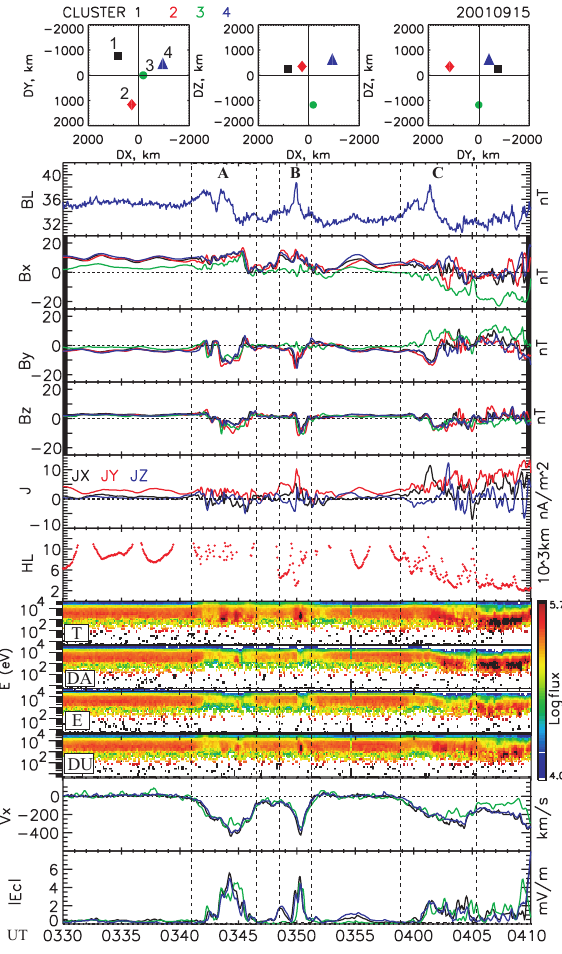
Fig. 2. Cluster spacecraft configuration and Cluster observations during 03:30–04:10UT on 15 September 2001. From top to bot- tom: The lobe magnetic field strength ( BL ), estimated assuming pressure balance; X , Y , and Z GSM components of the magnetic field from C1 (black), C2 (red), C3 (green) and C4 (blue); X , Y , and Z GSM components of the electric current, The Harris estimate of the current sheet half-thickness; Ion time-energy spectrograms from C3 HIA for tailward (T), dawnward (DA), Earthward (E), and duskward (DU) streaming sectors separately; Ion bulk velocities at C1, C3 and C4; The convective electric field E c =− V × B (absolute